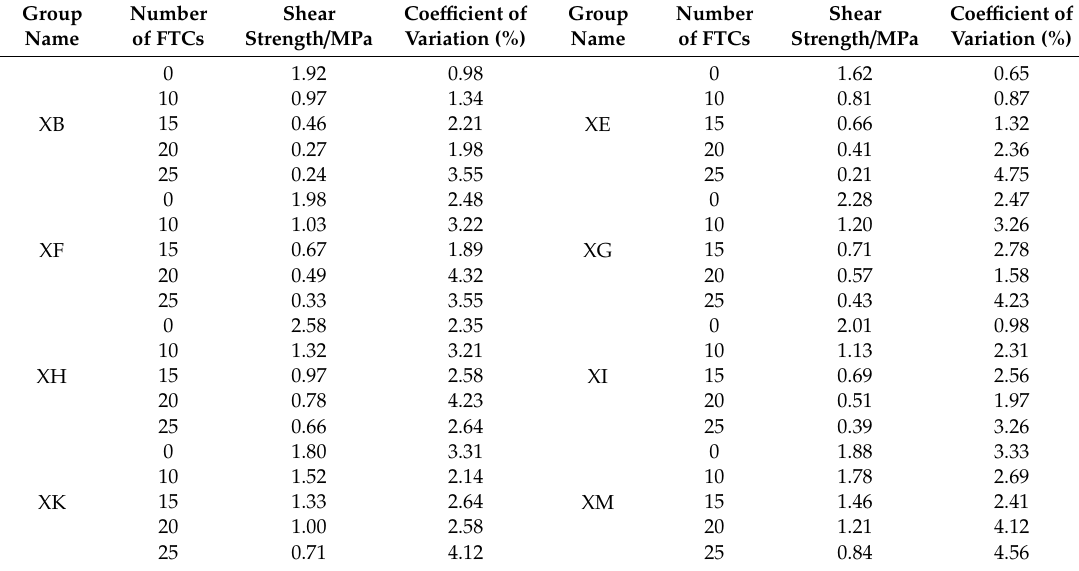
Table 2. The shear strengths of